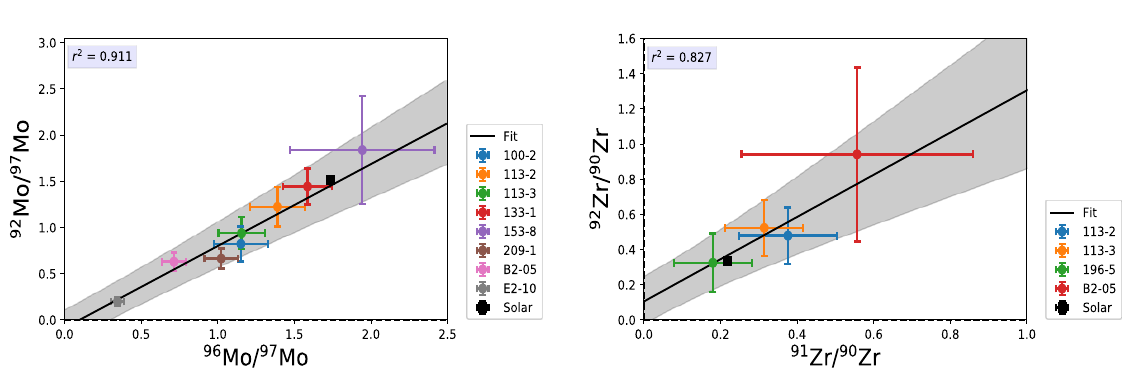
Figure 2. Molybdenum and Zr three-isotope plots for SiC-X grain data (2 σ uncertainties) from [34]. Solar composition is included for reference purposes. Also shown are the 2D linear regression fits to the data (solid line), the associated 2 σ errorband (shaded area) and quality of fit (r 2 ). Corresponding graphs for Ru not shown as there are only two SiC-X measurements, rendering a linear fit trivial. For completeness we also show the grain E2-10 for Mo (which was explored in the original analysis of [34] owing to the similar Mo isotope compositions of E2-10 and SiC-X grains) but exclude it from the fit. Regardless, the grain E2-10 falls on the mixing line.